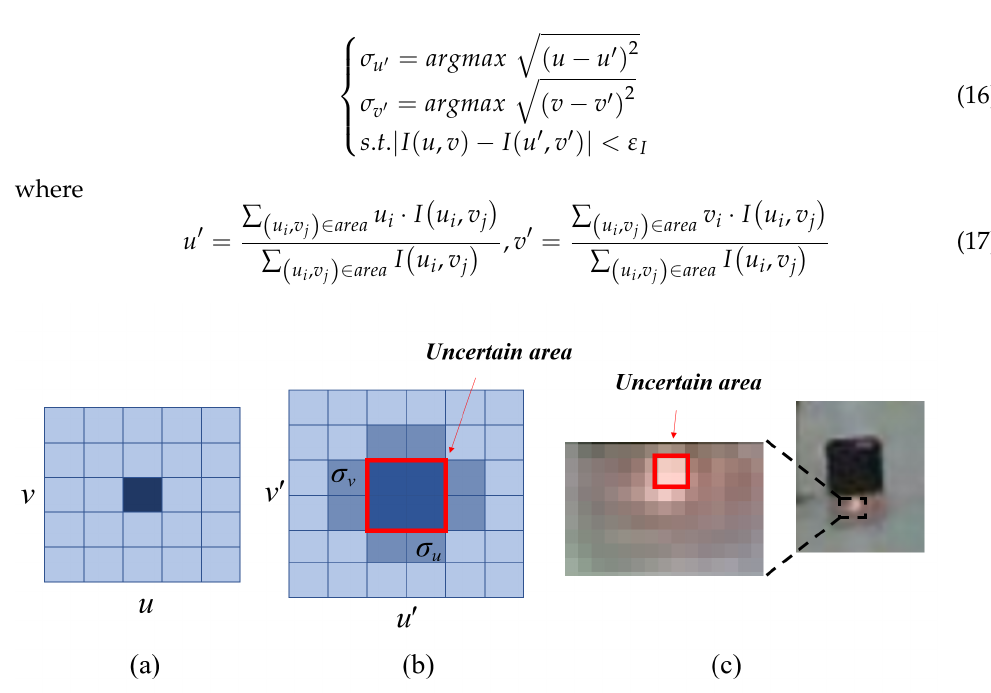
Figure 5. Schematic diagram of uncertainty representation of point. ( a ) Determined point, ( b ) uncertain point, ( c ) laser point on the laser detector card photographed by the